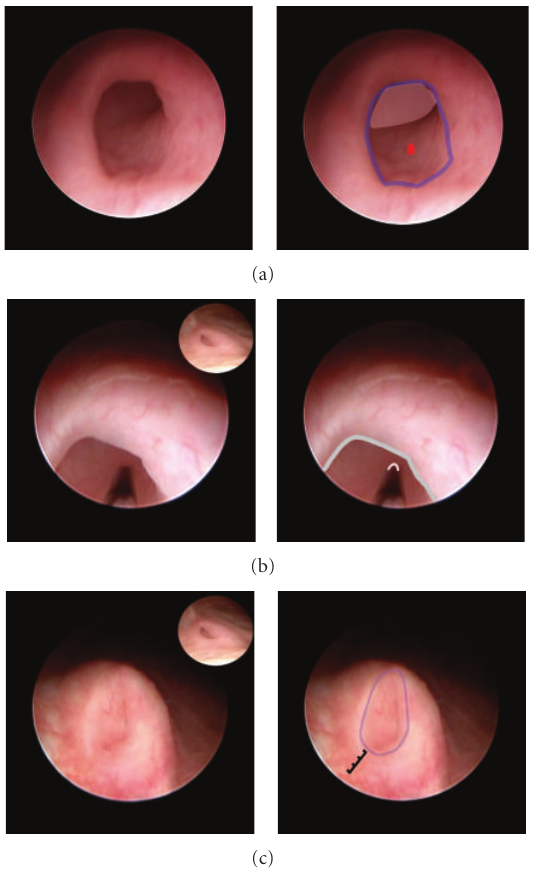
Figure 4: Procedure as CEVL components in a case of grade IV reflux in an infant girl. (a) Distal tunnel injection sequence. In- jection site is judged as the halfway mark between ureter orifice (blue ring) and last injection in the background (translucent over- lay). (b) Needle tip (left overlay) has penetrated mucosa and ready to inject implant. Orifice margin is noted (left overlay). (c) injection is completed as the mound of bulking implant (right overlay) obscures the lumen. The margin of the ureteral orifice is further elevated above the bladder surface (blue overlay) as shown by the graduated rule. This component is complete as the lumen beyond injection site is no longer evident and there is no evidence of